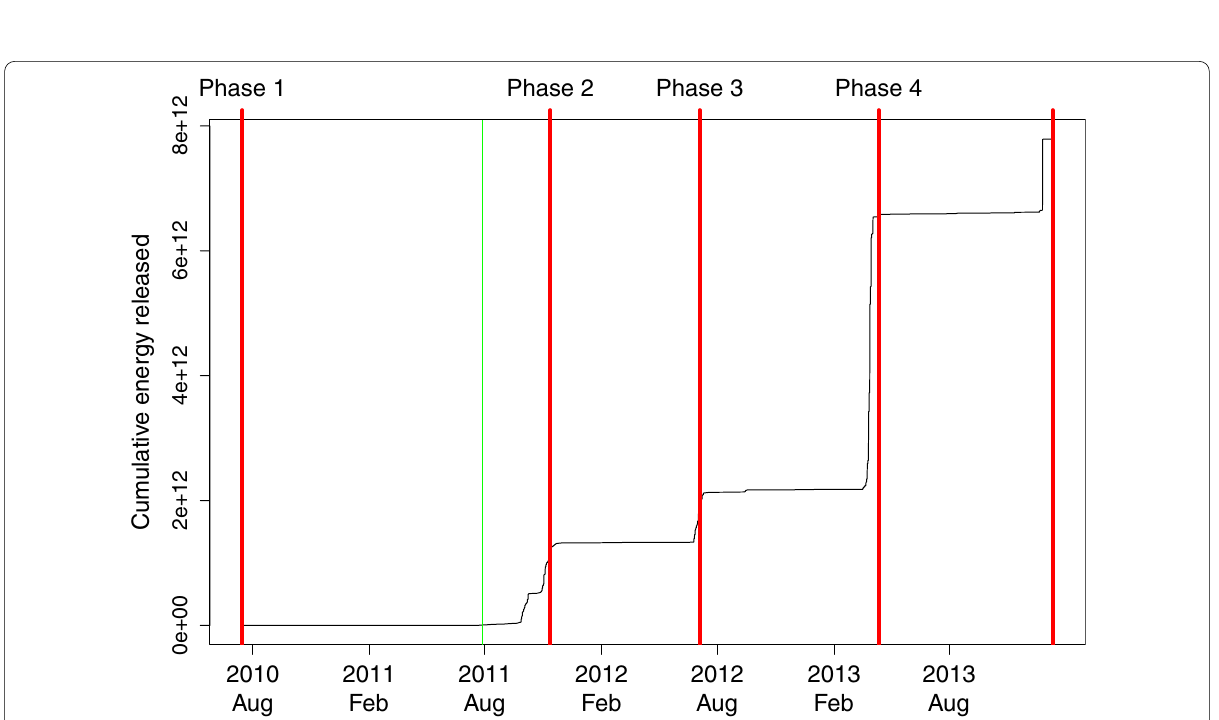
Fig. 5 Choosen phases on the data series cumulative energy released. In these data series the daily energy is considered to be